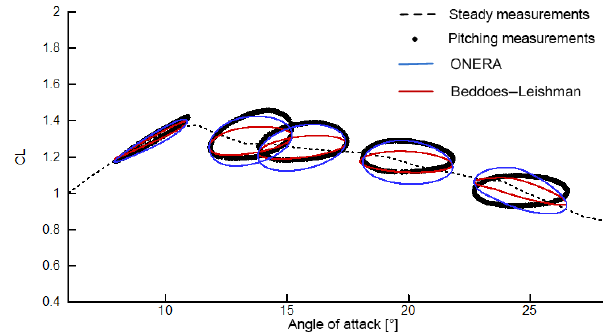
Figure 11. Comparison of engineering dynamic stall models against measurements. Results for a pitching FFA-W3-241. Mean angles of the five cases α 0 = 9 . 4 0 , 13 . 5 0 , 15 . 6 0 , 19 . 9 0 , 24 . 6 0 ; am- plitudes of the five cases α 1 = 1 . 5 0 , 1 . 7 0 , 1 . 8 0 , 1 . 9 0 , 1 . 9 0 ; reduced frequency k = 0 . 093 (Fuglsang et al.,